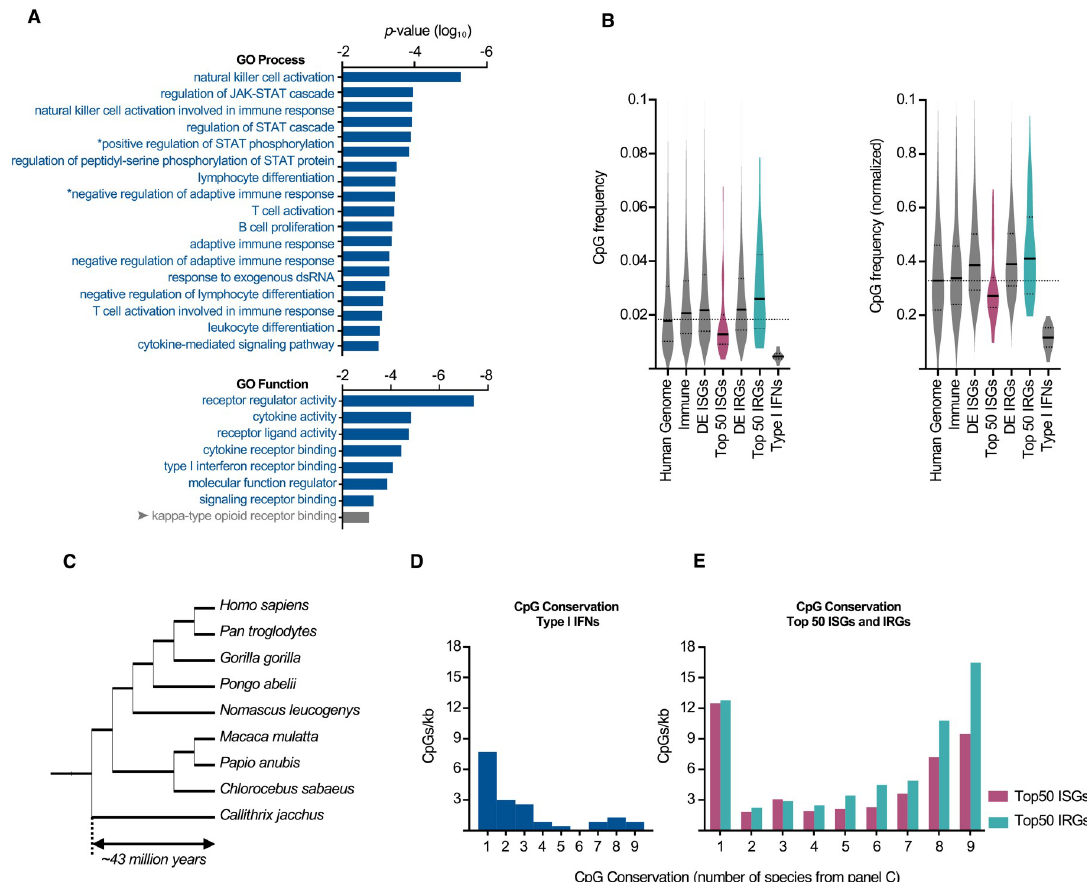
Fig 3. Type I IFNs exhibit extreme CpG suppression. (A) Significantly enriched GO processes and functions identified through GOrilla enrichment analysis of the 1,000 most CpG-suppressed cDNAs > 100 bp (compared to all cDNAs > 100 bp). (B) The CpG frequency in immune genes, ISGs, IRGs, and type I IFNs (for ISGs and IRGs, all significantly DE genes and the top 50 most DE genes are plotted). Matrices highlighting the significance (Kruskal–Wallis rank sum test) of potential comparisons in Fig 3B are displayed in S6 Fig. (C) A phylogenetic tree of the 9 primate species used to quantify CpG conservation in Figs 3D, 3E, and 5D. (D, E) Conservation is plotted as the number of CpGs per kb, binned by the number of species that possess that specific CpG, where 1:1 orthologs exist. Bin “1” represents CpGs present in only 1 of the species, whereas bin “9” represents CpGs conserved in all of the 9 species considered. CpG conservation is plotted for (D) type I IFNs (4 1:1 orthologs) and (E) top 50 ISGs (30 1:1 orthologs) and IRGs (34 1:1 orthologs). � Full GO process names: “positive regulation of peptidyl-serine phosphorylation of STAT protein” and “negative regulation of adaptive immune response based on somatic recombination of immune receptors built from immunoglobulin superfamily domains.” Arrow indicates a function enriched by genes other than the IFN genes IFNA2 and IFNA14. The underlying data from this figure are openly available (http://dx.doi.org/10.5525/gla.researchdata.1159). DE, differentially expressed; dsRNA, double-stranded RNA; GO, gene ontology; IFN, interferon; IRG, interferon-repressed gene; ISG, interferon-stimulated